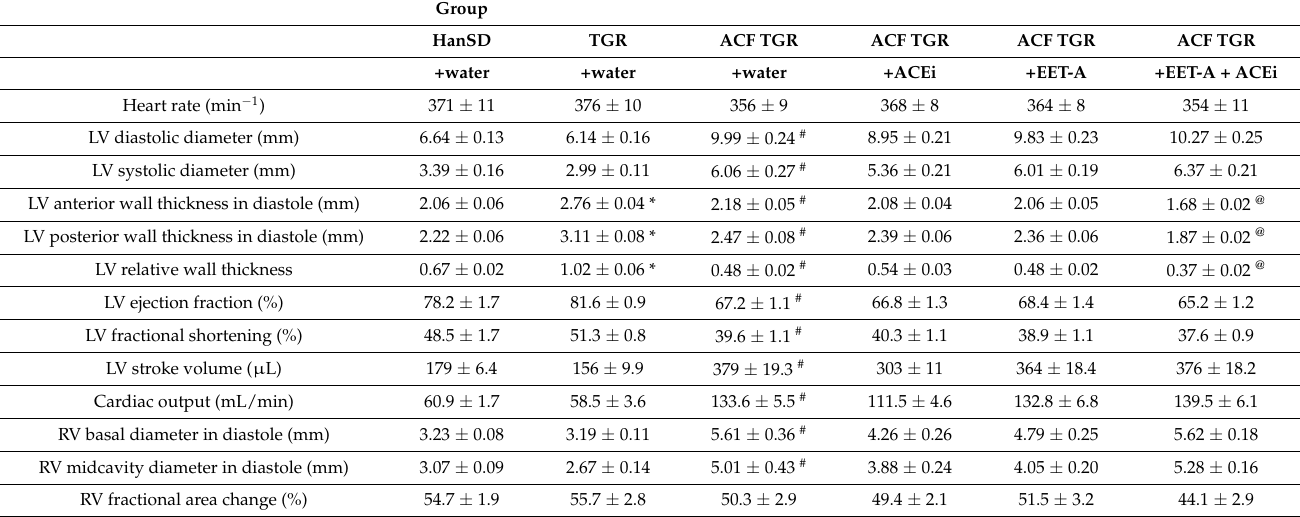
Table 3. Echocardiographic analysis 4 weeks after the induction of aorto-caval fistula (ACF) or sham-operation and after 2 weeks’ treatment with 14,15-epoxyeicosatrienoic acids analog (EET-A) and angiotensin-converting enzyme inhibitor (ACEi) alone or combined with